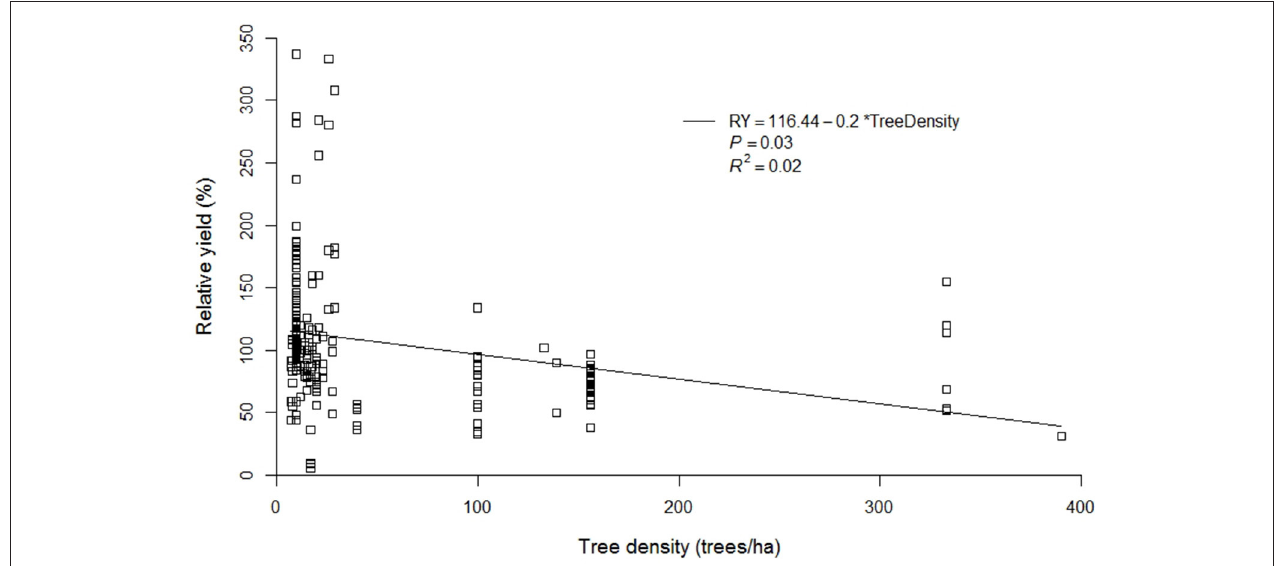
FIGURE 5 | Plot of relative crop yields against tree density. The symbols distinguish experimental sites of data points. The regression line was fitted with Model 3 ( Table 2 ).